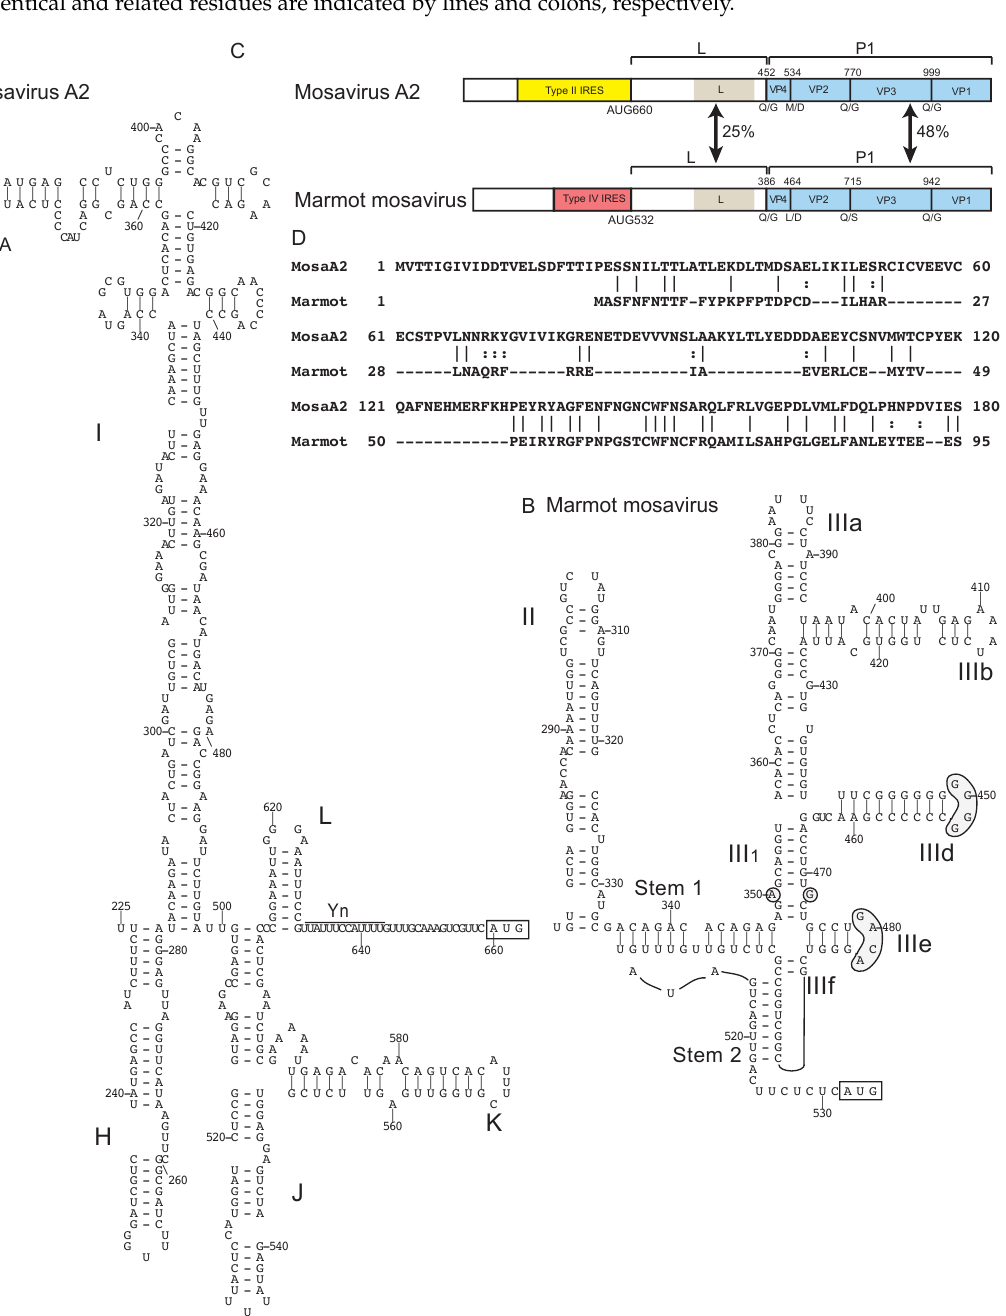
in domain III that are conserved in other type IV IRESs, such as the apical loops in subdomains IIIa, IIId and IIIe, and the unpaired purine residues in helix III 1 (grey shading). The tertiary base-pairing interaction between one of these unpaired purine residues in helix III 1 and a flipped-out pyrimidine residue in the loop of subdomain IIIe is indicated by a blue line. ( C ) Schematic representations of the 5 (cid:48) UTRs and adjacent coding region for the P1 capsid protein precursor, annotated to show noncoding regions that constitute the type I IRES in crohivirus A (light blue) and the type IV IRES in crohivirus B (red), the N-termini of the structural proteins VP4, VP2, VP3 and VP1 and the protease cleavage sites between them, and the amino acid sequence identity between the two P1 polyproteins. ( D ) Sequence alignment of the N-terminal regions of the VP4 proteins of crohivirus A and crohivirus B. Identical and related residues are indicated by lines and colons, respectively.